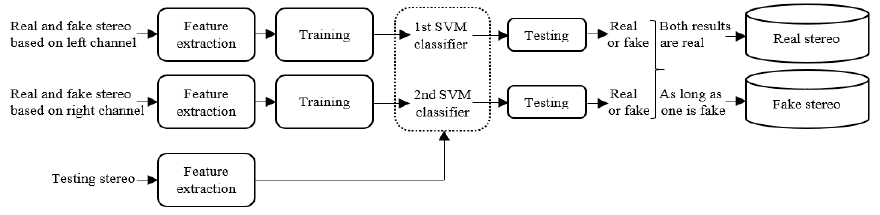
Figure 5. MFCC features and SVM classification algorithm